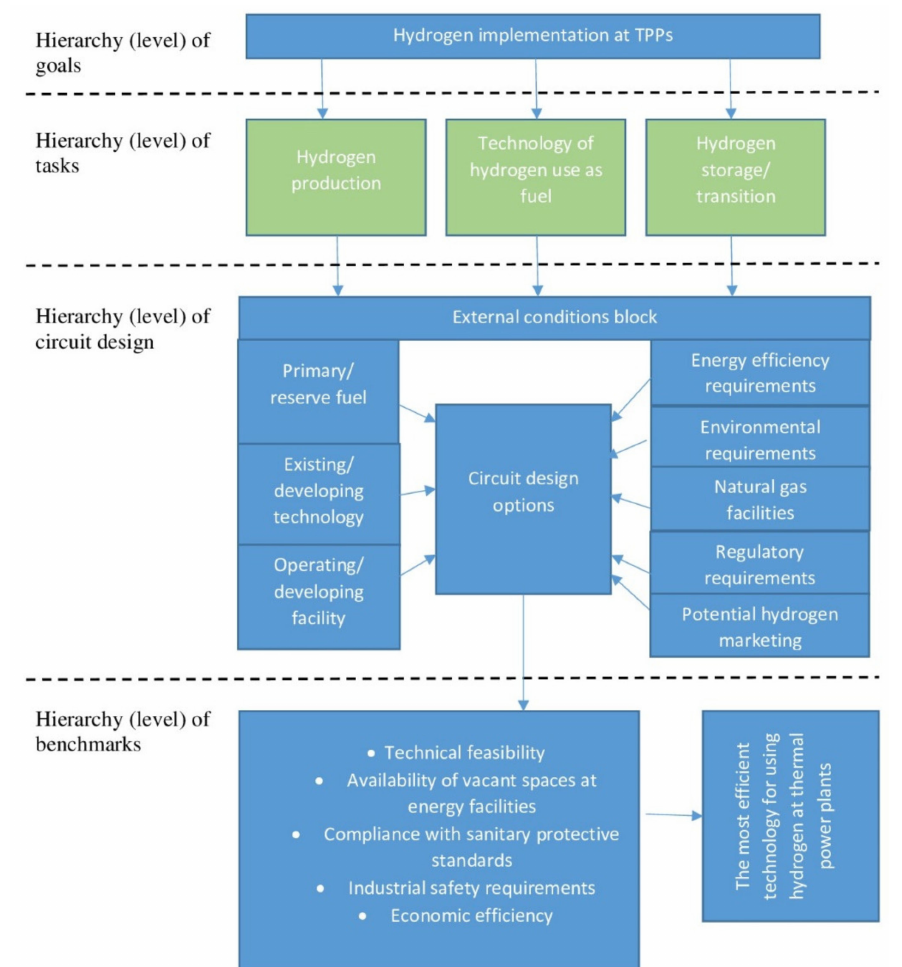
Figure 2. Flowchart of the algorithm for determining optimal solutions for technology integration of the usage, transportation, and storage of hydrogen, applicably to the operating